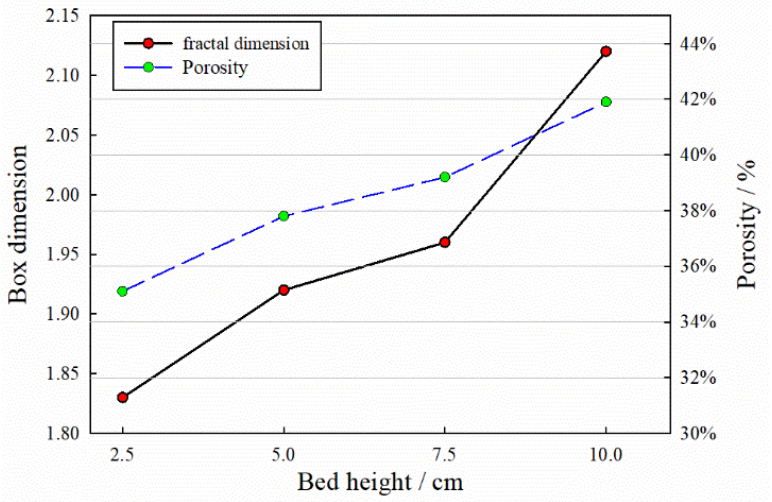
Figure 6. Box dimension and porosity in the bed.